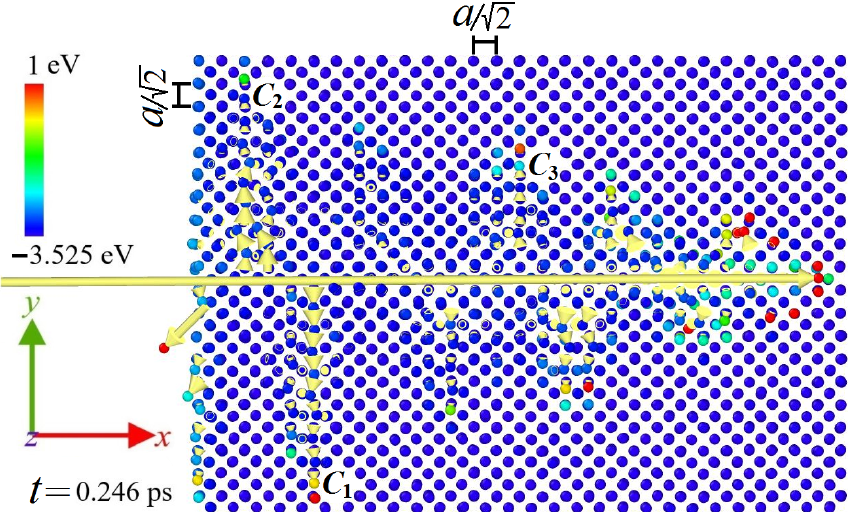
Figure 8. The dynamics of the bombarding atom in fcc copper along the octahedral channel, i.e., along the x axis (shown by a horizontal yellow arrow). The short yellow arrows along the y axis demonstrate the direction of movement of the excited crowdions C 1 , C 2 , and C 3 . The results are presented for the time instant of t = 0.246 ps. For this particular case, V x = 450Å/ps and ∆ y =0.3Å (case